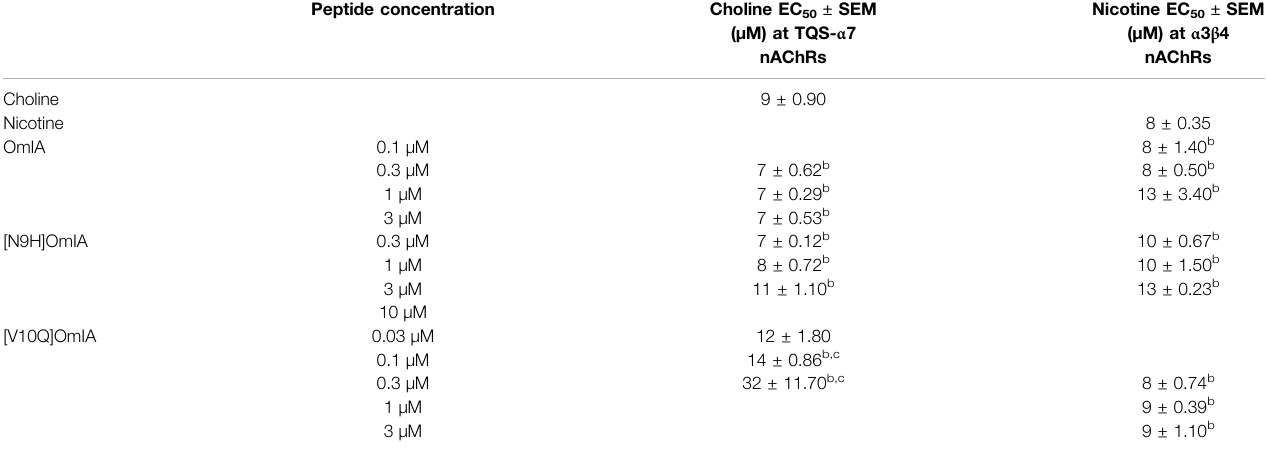
TABLE 4 | Effect of OmIA and its analogues on choline concentration-activation curve at α 7 nAChRs with the addition of nAChR type II PAM, TQS and on nicotine concentration-activationcurveat α 3 β 4nAChRs inSH-SY5Ycells. b denotes95%CIsforcurvetopvaluesnon-overlapping100%. c denotessigni fi cantdifference inEC 50 values to agonist alone ( p < 0.05). Data represent mean ± SEM of triplicate data from three independent experiments. Peptide